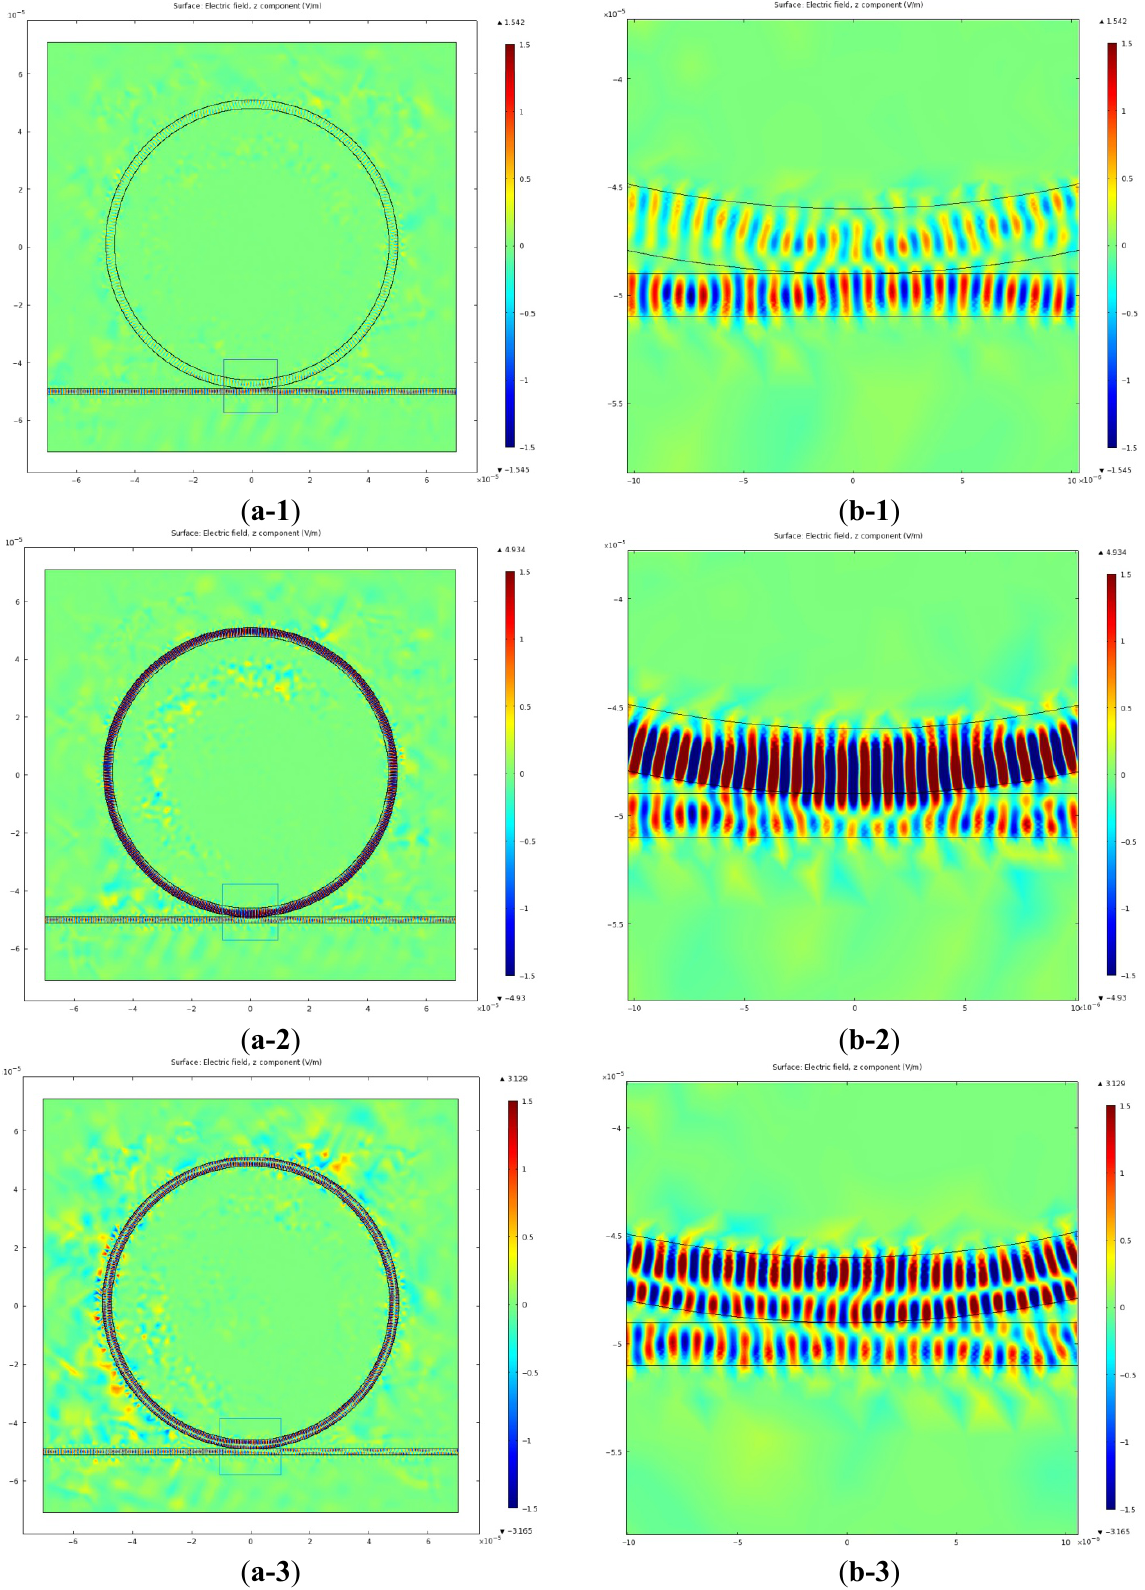
Figure 3. Electric fields distributions for the ring-waveguide coupling part (d = 100 μ m, t = 3 μ m, w = 2 μ m, g = 0 μ m); ( a ) the regular plots and ( b ) the magnified plots. (Off-resonance ( a-1 , b-1 ); first-order resonance ( a-2 , b-2 ); second-order resonance ( a-3 , b-3